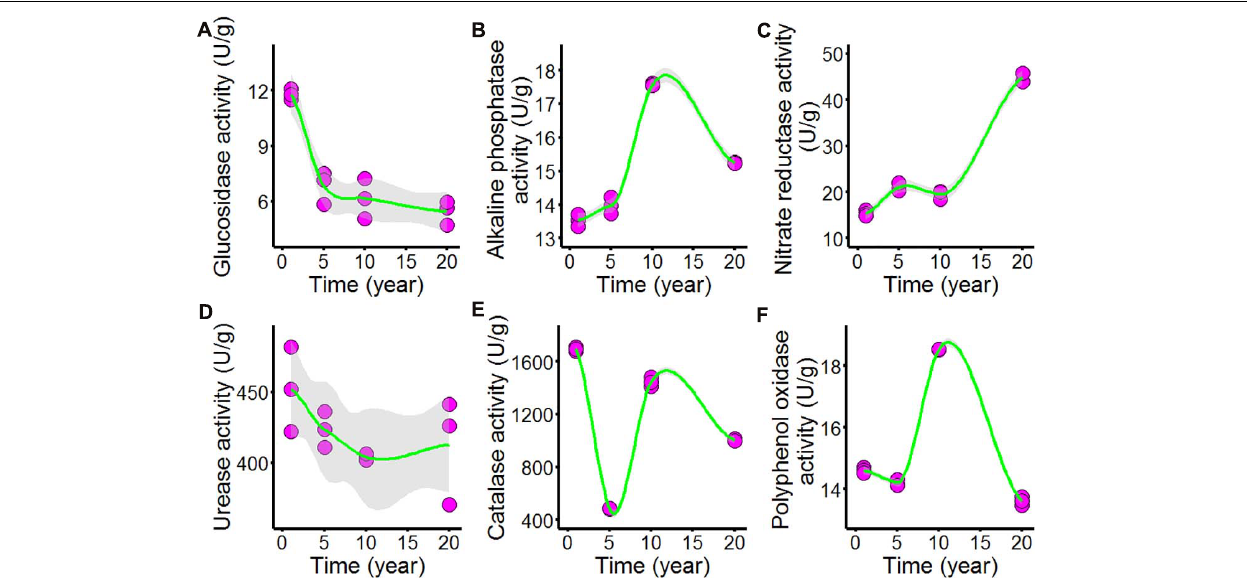
FIGURE 3 | Effect of long-term chili monoculture on the enzyme activities of rhizosphere soil. Long-term chili monoculture altered the activities of µ -glucosidase (A) , alkaline phosphatase (B) , nitrate reductase (C) , urease (D) , catalase (E) , and polyphenol oxidase (F) . Soil enzymatic levels show different patterns of response to continuous cropping duration (1, 5, 10, and 20 years). Solid lines represent LOESS fits, and gray areas denote the 95% confidence intervals.